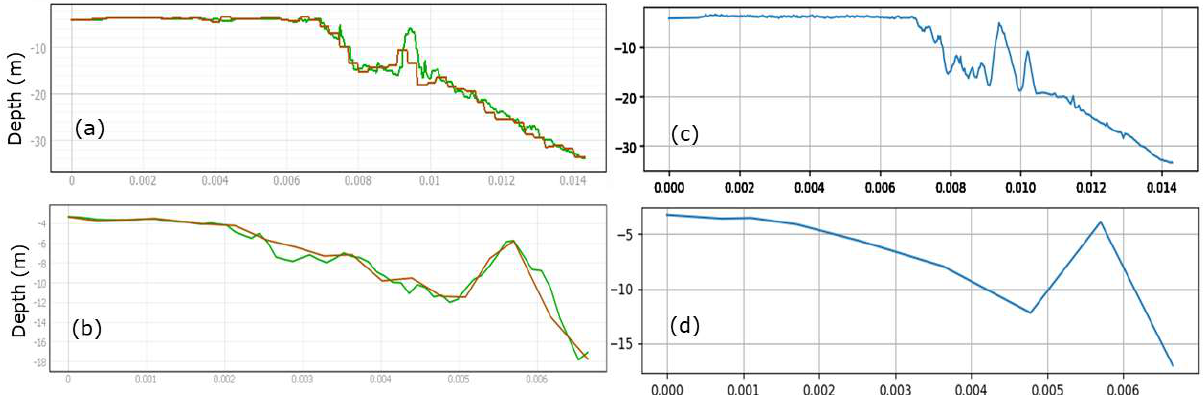
Figure 5. Cross profile showing comparison between SDB model from GWR applied on Sentinel-2A (green line) and Landsat 8 OLI/TIRS (brown line) for AoI-1 (a) and AoI-2 (b); and the profiles of their related SBES measurements for AoI-1 (c) and AoI-2 (d). The cross-profile location is indicated as black line in Figure 6.